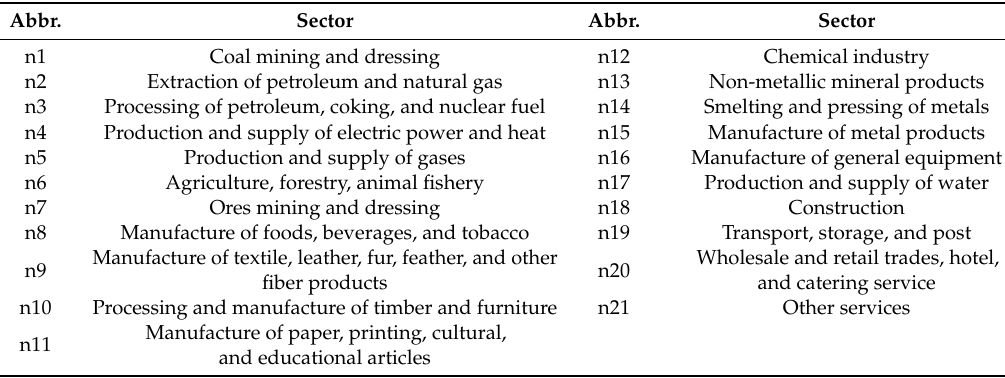
Table 3. Sectors in China’s input-output